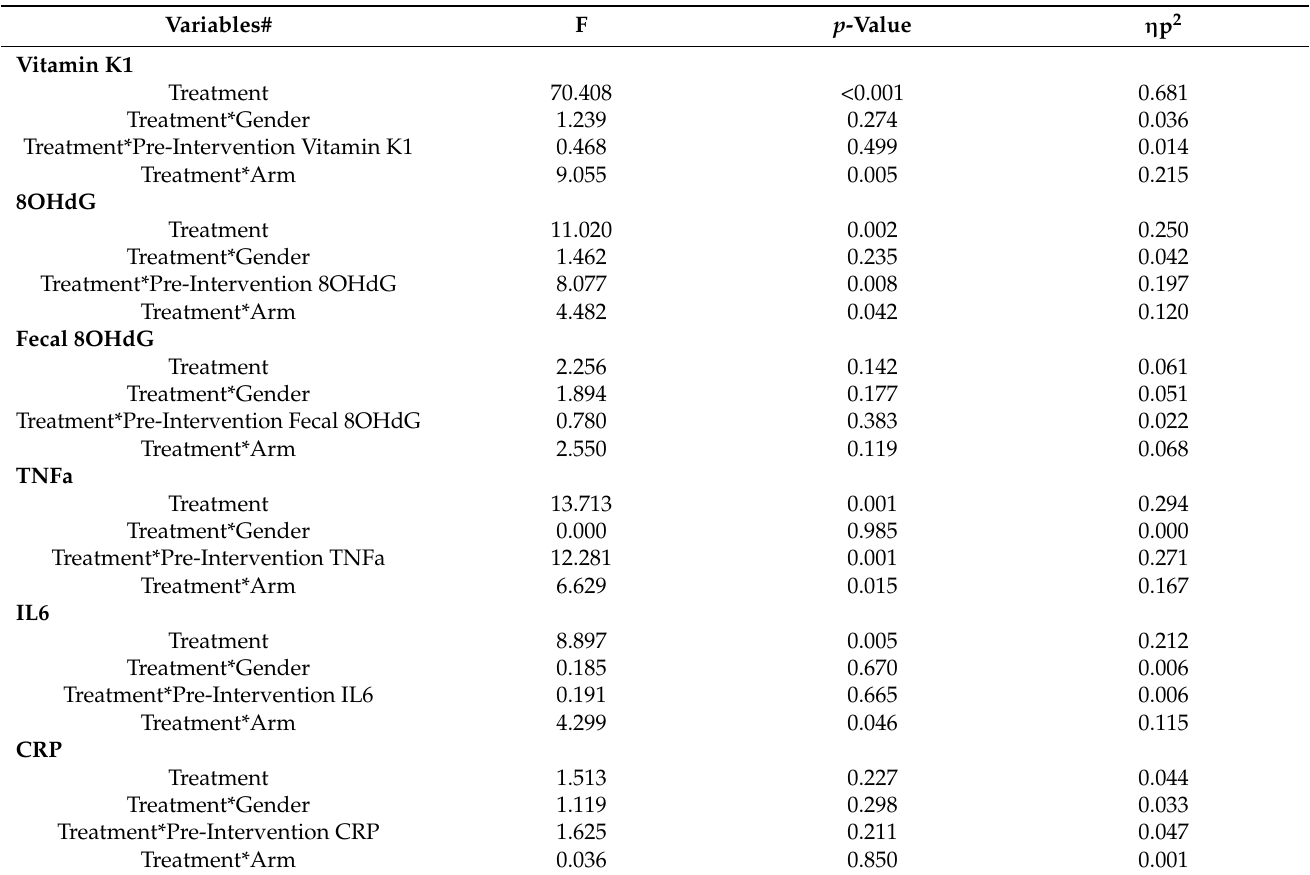
Table 3. Analysis of Covariance results for biological outcomes within participants in a randomized controlled crossover high green leafy vegetable dietary